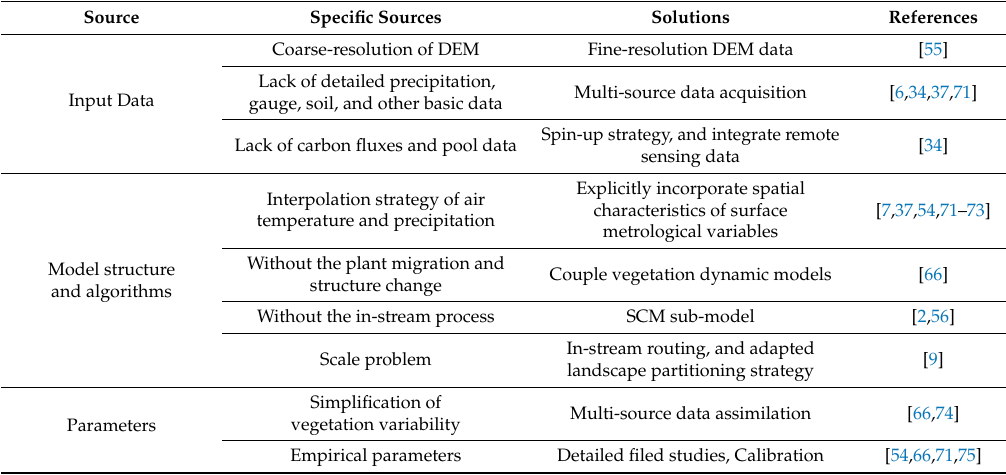
Table 4. Sources and corresponding solutions of uncertainties in